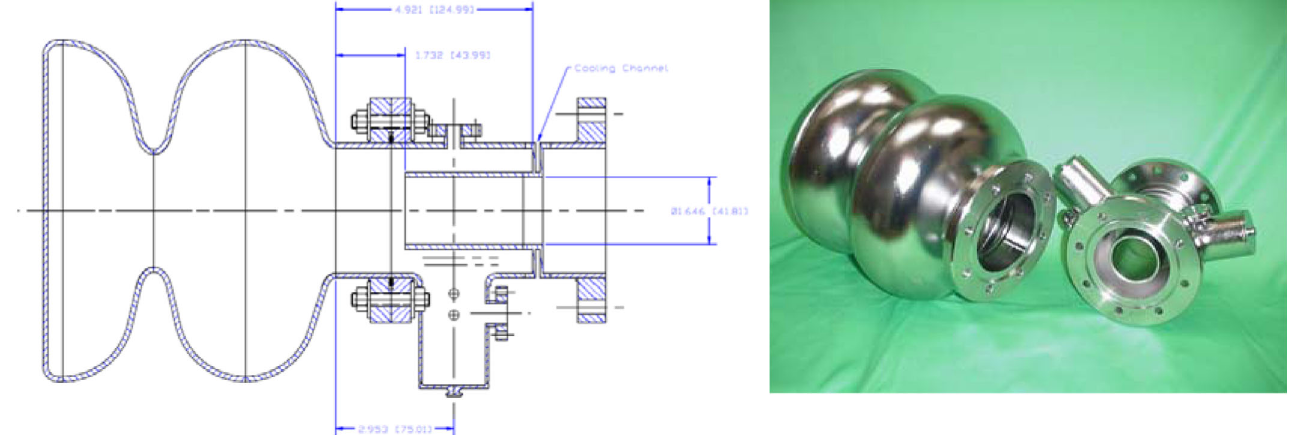
FIG. 3. (Color) 1.6-cell SRF gun cavity and coaxial coupling device: assembly drawing and parts before